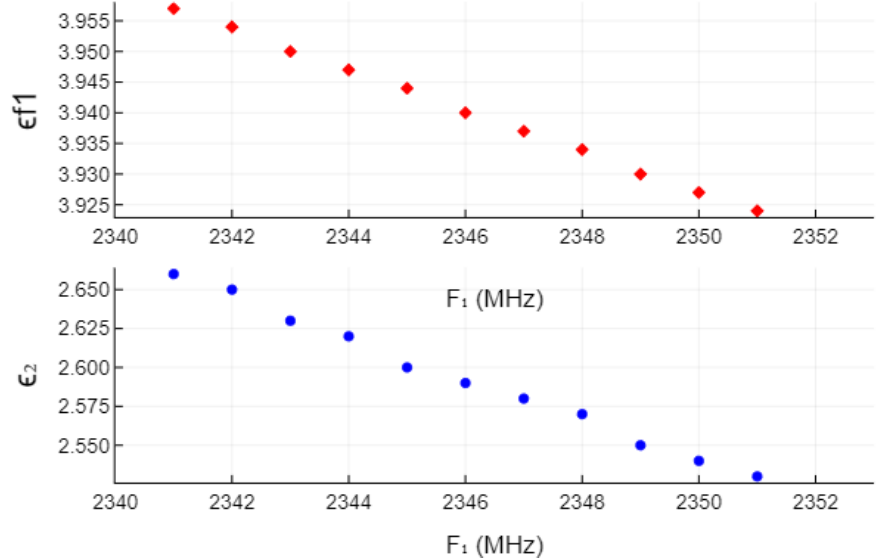
Figure 12. An example of change of the evaluated value of (cid:101) f 1 and (cid:101) 2 , with respect to F 1 , when F 1 varies ± 5 MHz around the central value at 2346 MHz for an SUT of 4.13 mm thick plexiglass. The change in the results of (cid:101) f 1 and (cid:101) 2 for the lowermost frequency point (2341 MHz) with respect to the central point (2346 MHz) is the following: the relative discrepancy in F 1 is − 0.21%, for which the discrepancy in the value of (cid:101) f 1 is 0.43%, but the discrepancy in the value of (cid:101) 2 is 2.7%. It speaks something about the sensitivity of the result to the